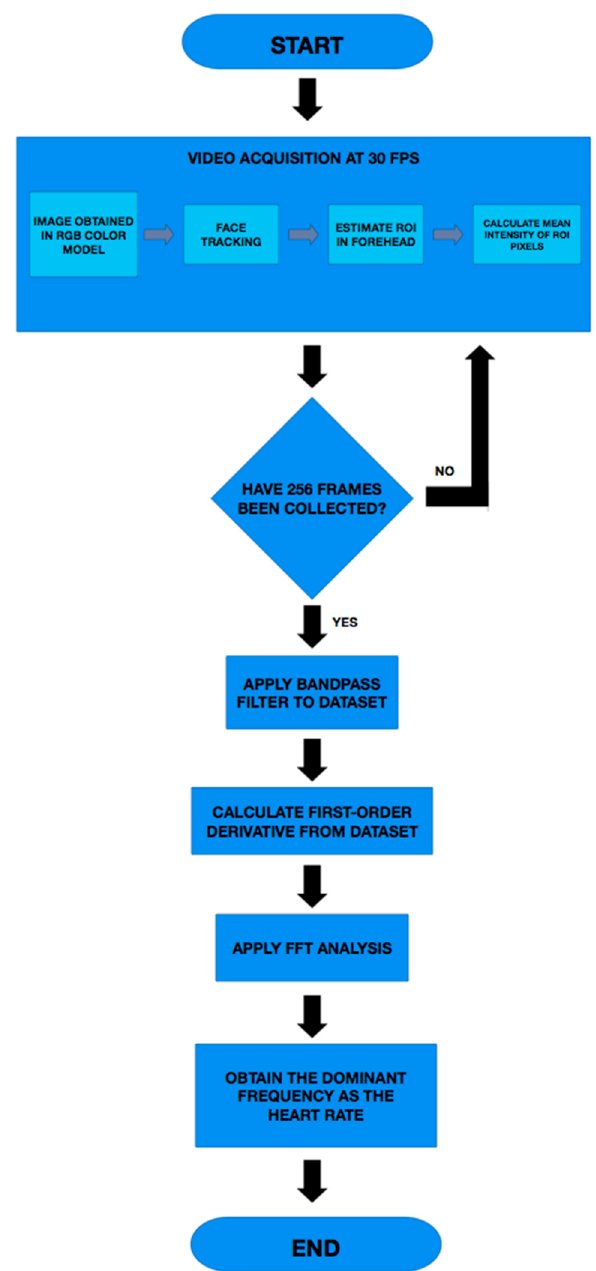
Figure 2. Flowchart of the process implemented in the application.